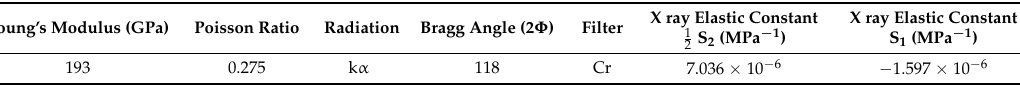
Figure 2. Method of sample preparation for X-ray diffraction (XRD) analysis. Table 2 . Parameters for X-ray residual stress analysis.